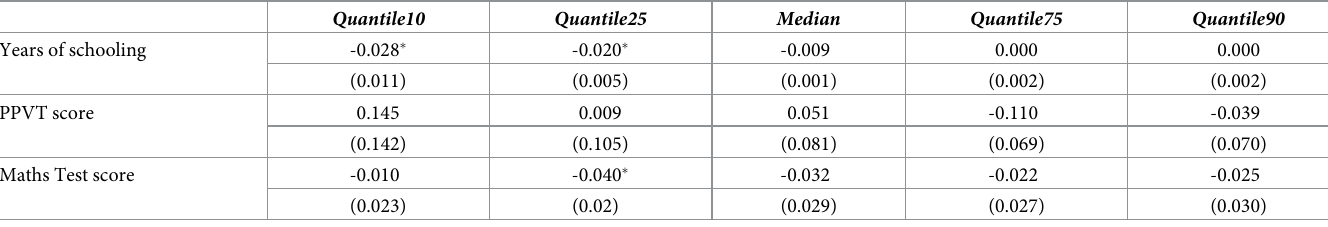
Table 6. Quantile regression coefficients of RWG on educational outcomes @ .